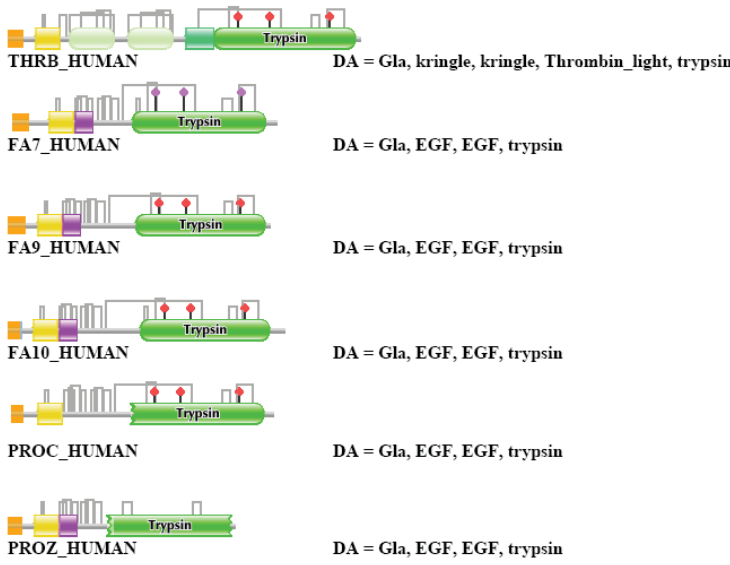
Figure S2. Comparison of the domain architectures of THRB_HUMAN and its closest human